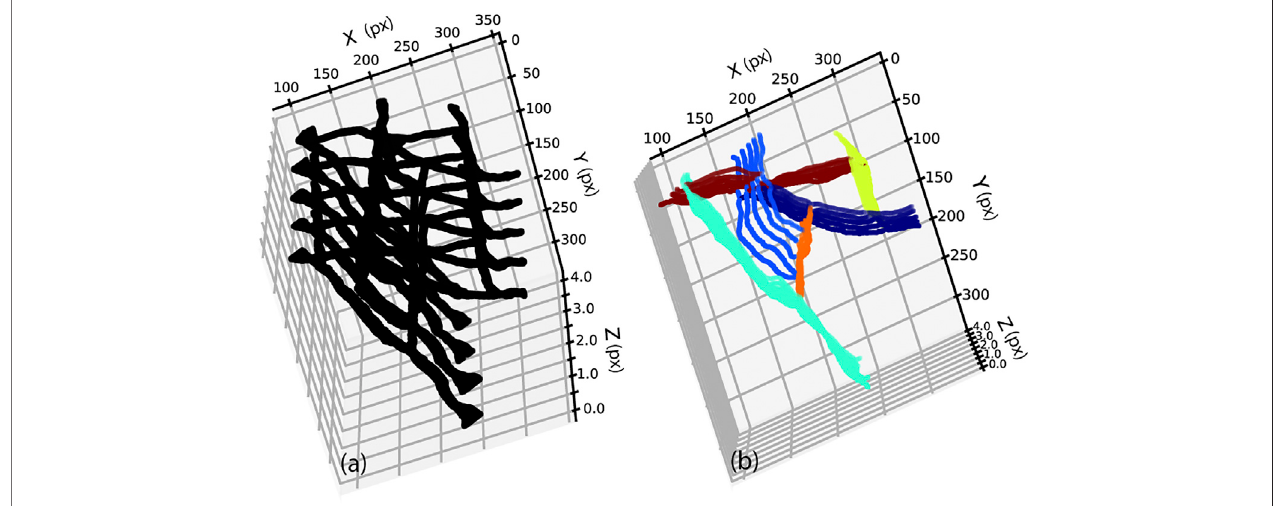
FIGURE5| 3Dbinaryimage( fi veslices) of (A) openand connectedfracturesdetected inCTscansofdrillcorescollectedduringtheAlpineFault,DeepFaultDrilling Project (Toy et al., 2015) (B) . The network has been skeletonized and broken apart into 2D fracture segments that are analyzed and connected in 3D using geometrical and orientation similarities explained further in the text. Different colors indicate different labels.